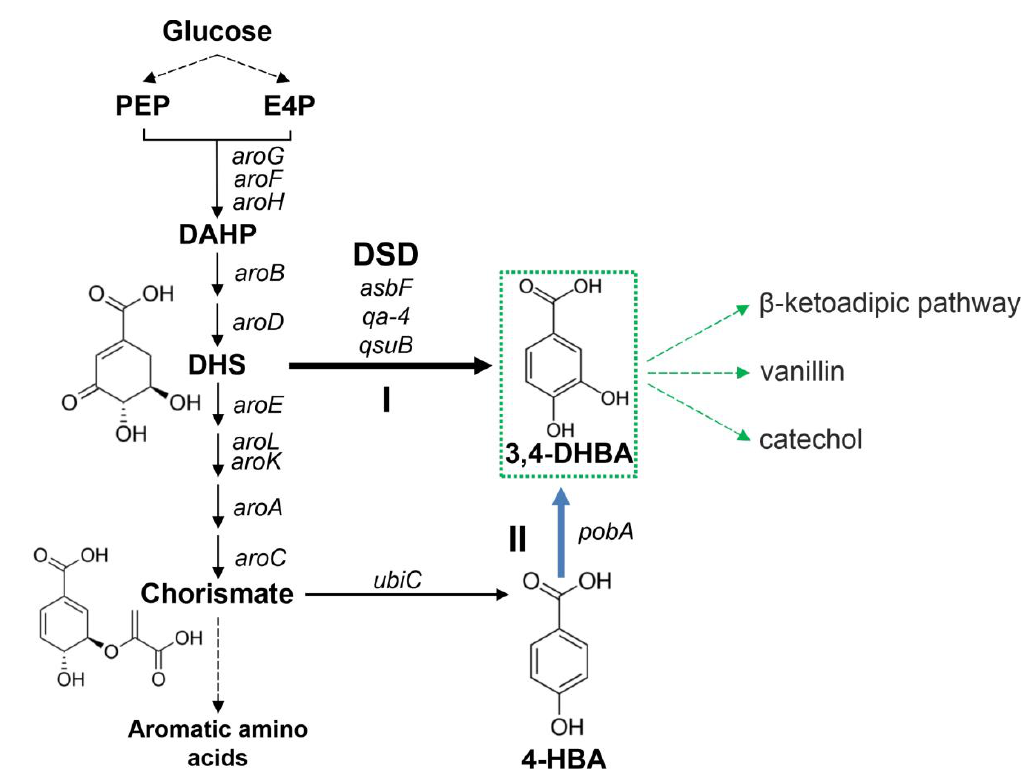
Figure 1. Two routes of 3,4-DHBA biosynthesis (I and II) from glucose. The reactions of common aromatic pathway, which start from condensation of phosphoenolpyruvate (PEP) and erythrose-4-phosphate (E4P) with the formation of 3-deoxy-D-arabino-heptulosonate-7-phosphate (DAHP), are denoted as E. coli gene names. aroG , aroF , aroH — DAHP-synthases; aroB — 3-dehydroquinate synthase; aroD — 3-dehydroquinate dehydratase; aroE — shikimate 5-dehydrogenase; aroL , aroK — shikimate kinases; aroA — 5-enolpyruvylshikimate 3-phosphate synthase; aroC — chorismate synthase. Bold black and blue lines indicated steps catalyzed by heterologous enzymes. asbF , qsuB , qa -4 — DSDs investigated in this work. ubiC — chorismate lyase; pobA — 4-hydroxybenzoate (4-HBA) 3-monooxygenase.